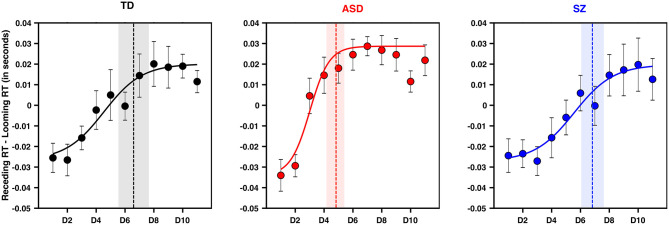
PPS is smaller and sharper in ASD than TD and SZ. Y-axis is the difference between tactile RTs during approaching and receding visual stimuli when matched for time. X-axis is distance, in the frame of reference of the approaching stimuli. Namely, D1 corresponds to D1 for approaching, and D11 for receding (which are matched in time). Negative values along the y-axis indicate a further facilitation as a function of distance for approaching than for receding visual stimuli, as would be expected of a PPS effect. Error bars are ±1 S.E.M., the vertical line in each panel (TD = black, ASD = red, SZ = blue) is the average central point of the sigmoidal fit (the fit shown is for the average subject). Shaded area is ±1 S.E.M.